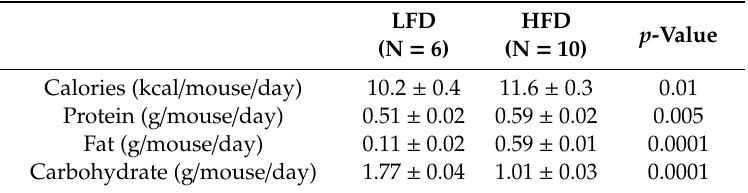
Table 1. Food consumption of females fed a high-fat diet (HFD) or low-fat diet (LFD) for 13 weeks prior to mating. Females were group-housed and so consumption was calculated for cages, not individual mice.